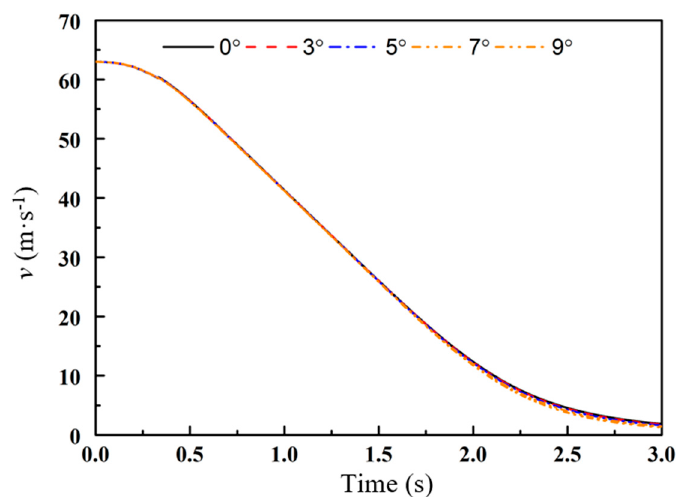
Figure 16. Figure 16. Velocity–time. Figure 16. Velocity–time.